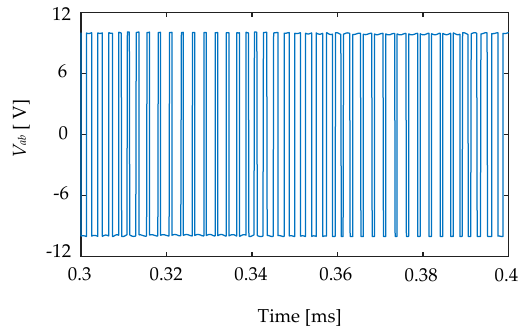
Figure 5. The output voltage V ab of the inverter.